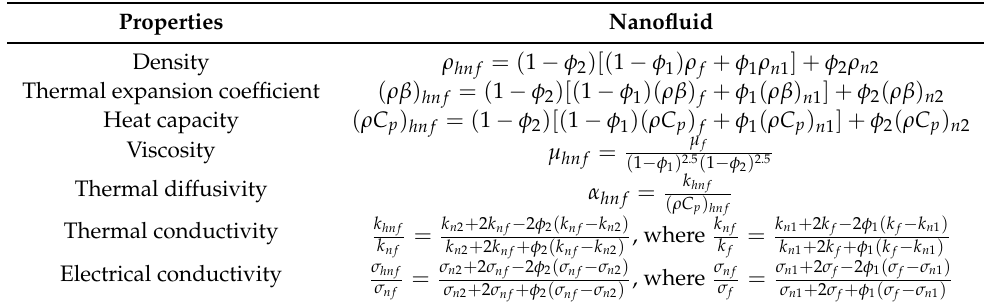
Table 3. Thermophysical properties of hybrid nanofluid (type II) [35].